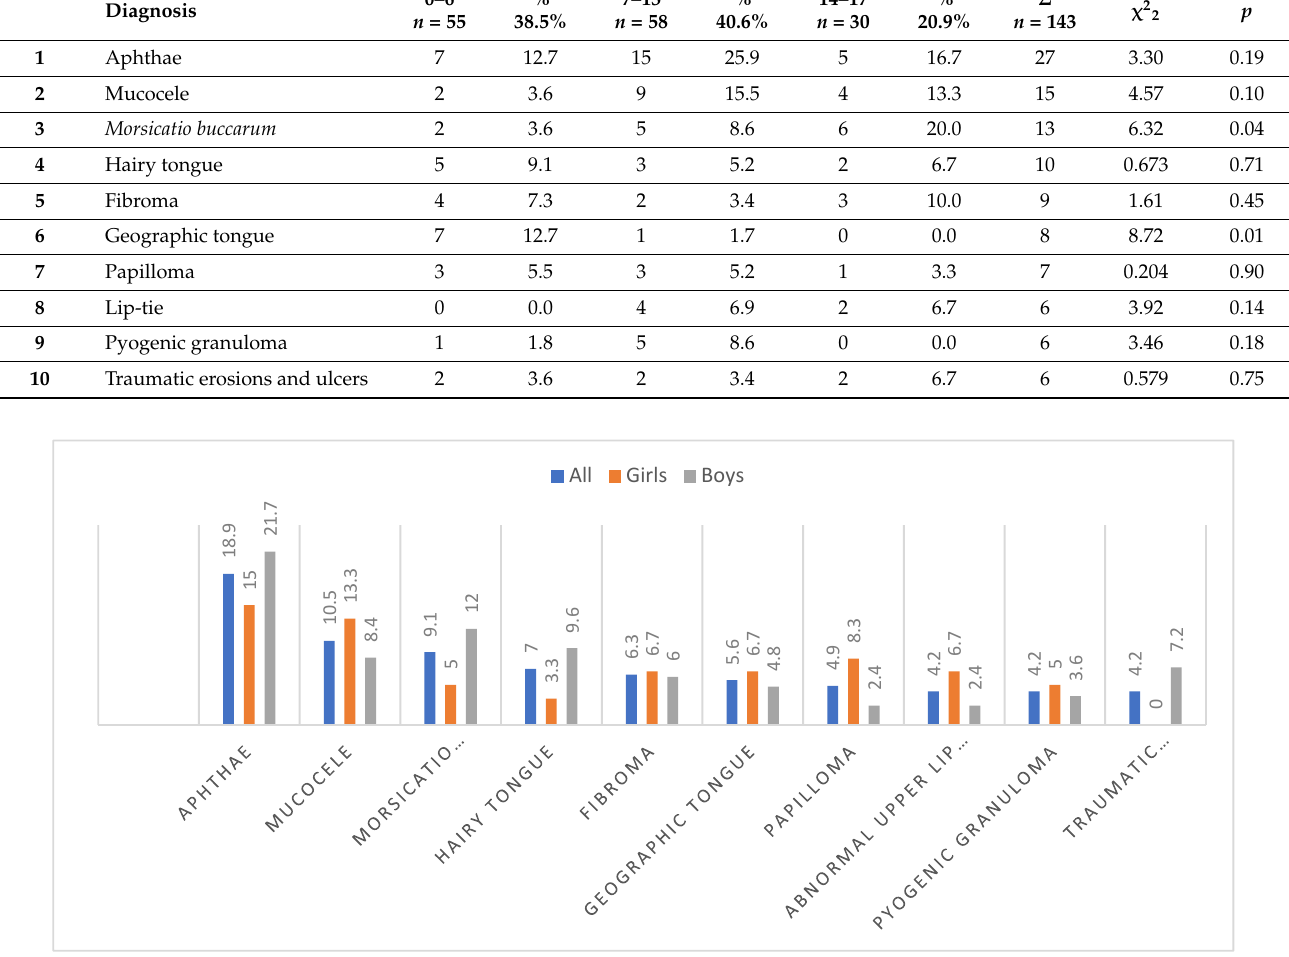
Figure 1. Distribution of the 10 most common OMLs by gender, in percentage.